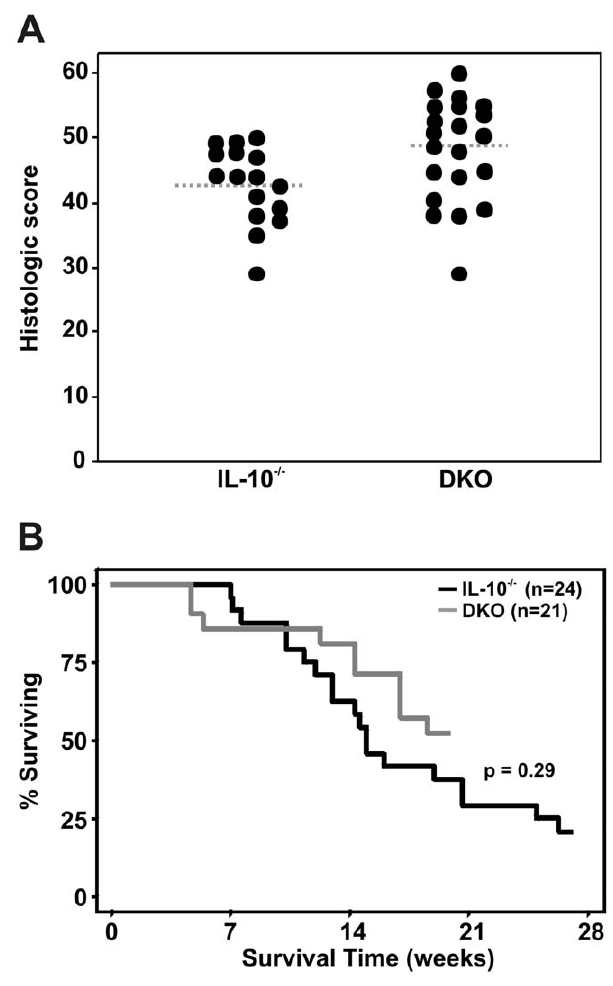
Figure 5. Mast cells do not affect long-term colitis severity in Helicobacter-infected Il10 2 / 2 mice. Il10 2 / 2 mice with (n=21) and without (n=24) genetic deficiency of mast cells were infected with H. rodentium and H. typhlonius and monitored for up to 27 wks. DKO mice had a small increase in histologic score compared with mice deficient in IL-10 alone (A; p=0.03), but there was no difference in survival between DKO and mast cell-sufficient Il10 2 / 2 mice (B).